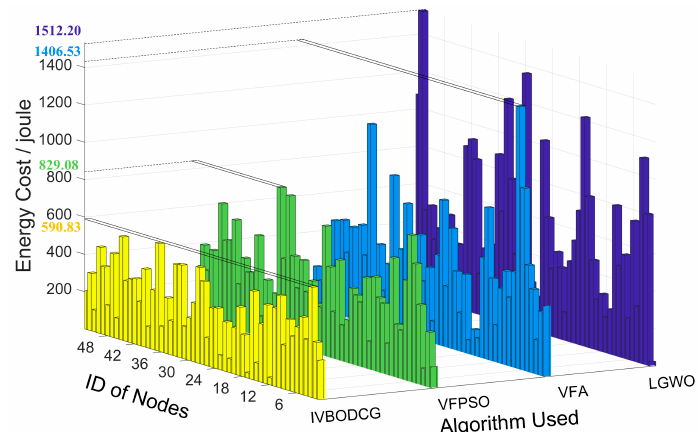
Figure 12. Energy cost for 53 sensors of IVBODCG, VFPSO, VFA and LGWO. The yellow, green, light blue, and dark blue bar graphs are the energy cost of the 53 nodes of four algorithms, respectively, after redeployment. The bars from right to left in a given bar graph represent the energy cost of nodes 1–53 of the corresponding algorithm.